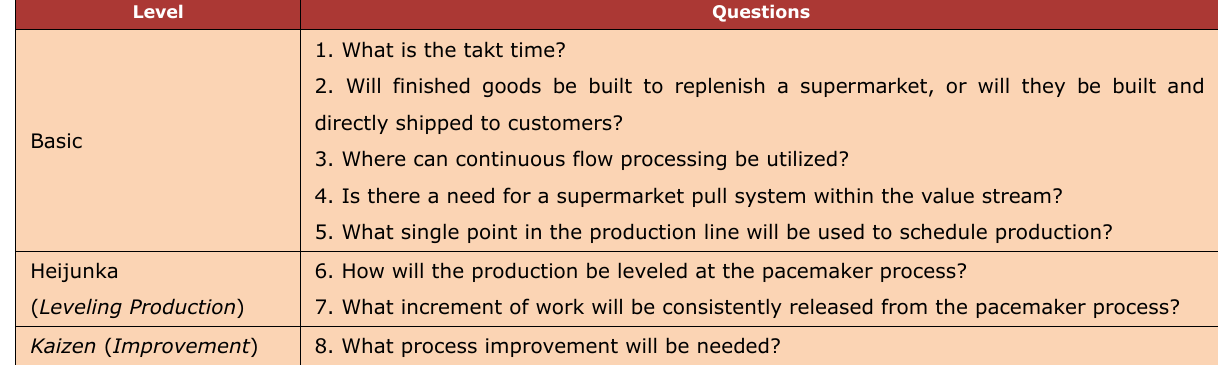
Table 2. Design questions for value stream